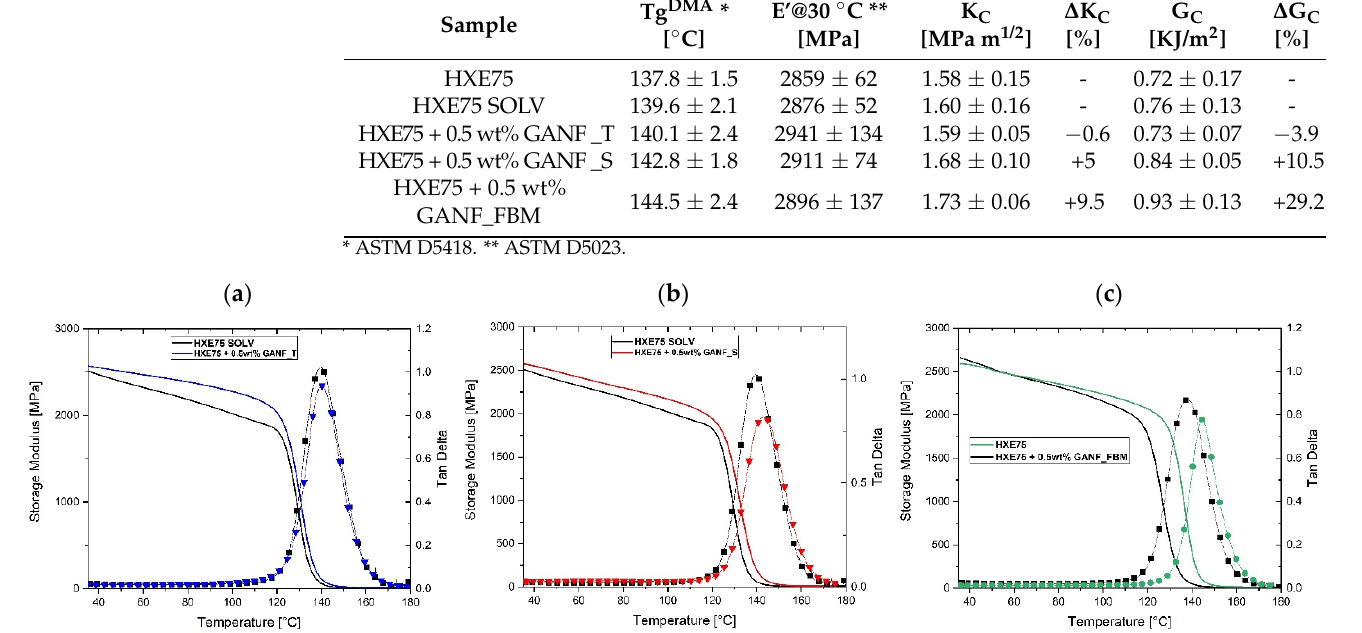
Figure 8. DMA analysis performed on the neat epoxy matrix and the GANF based nanocomposites.